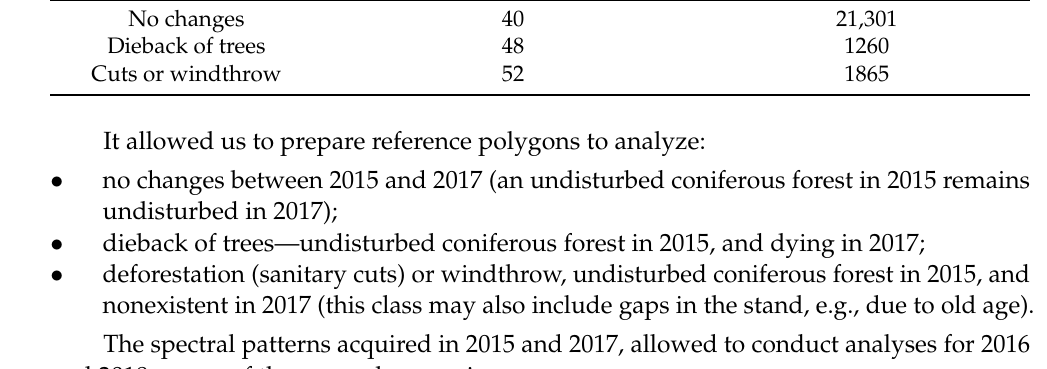
Table 2. Number of reference polygons and pixels between 2015 and 2017 used for change detection.